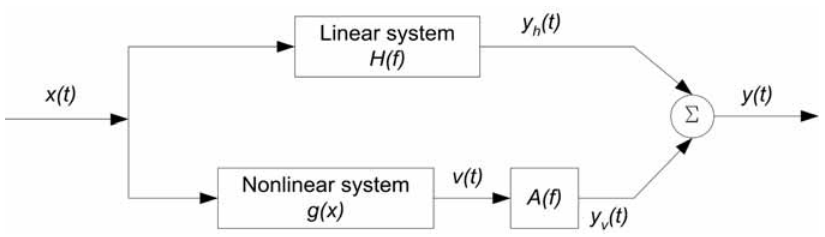
Fig. 1. Nonlinear MISO model block diagram.